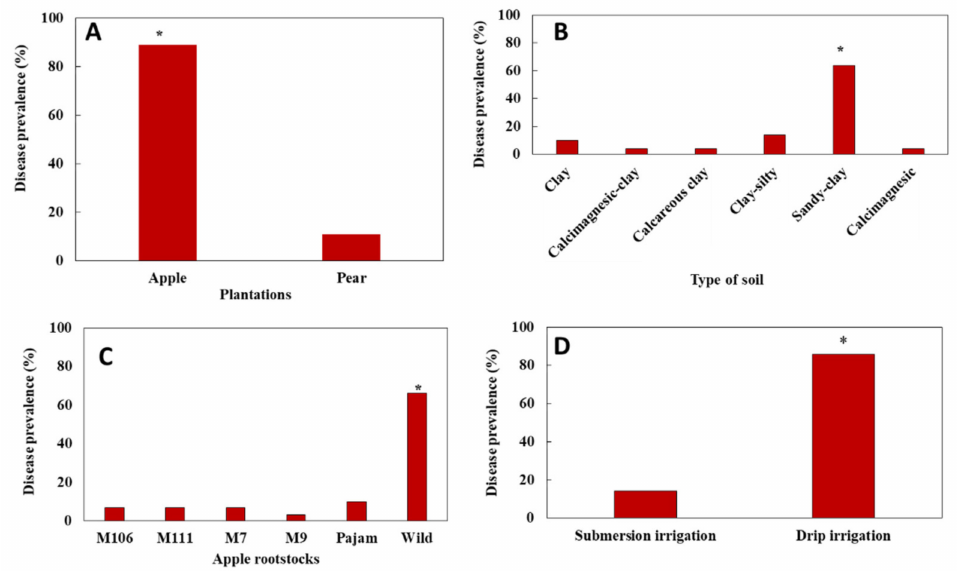
Figure 5. Disease prevalence (%) according to the type of plantation apple/pear tree ( A ), type of soil ( B ), apple rootstocks ( C ), and irrigation mode (submersion versus drip irrigation mode) in the surveyed orchards of Saïss plain ( D ). Asterisks (*) indicate significant effect ( p < 0.05) according to the Chi square analysis test ( χ 2